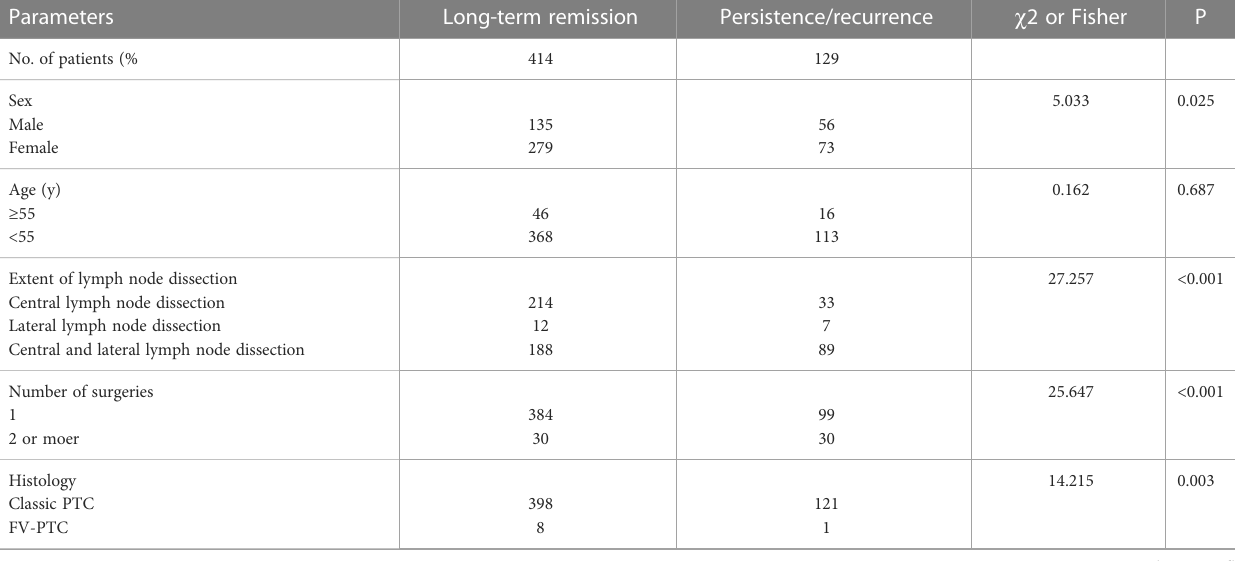
TABLE 2 Univariate analysis of predictors of persistent/recurrent disease. Parameters Long-term